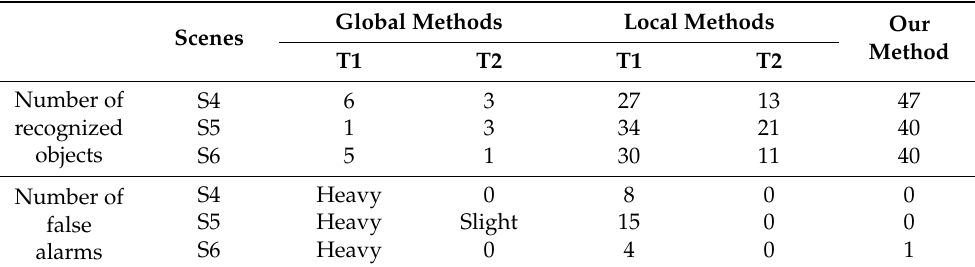
Table 1. Segmentation results of different star images with different methods.